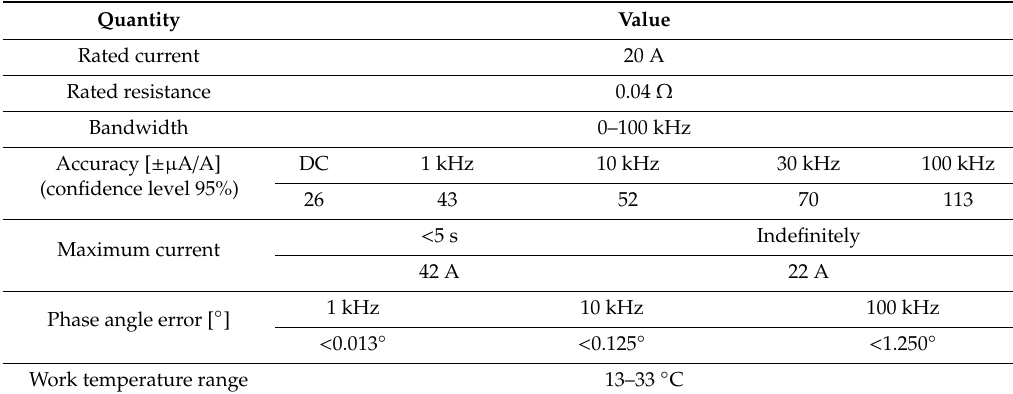
Table 5. Technical data for the A40 B shunt